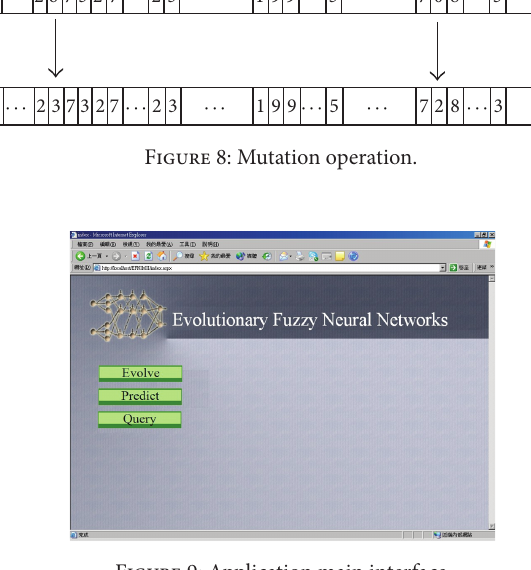
Figure 9: Application main interface.